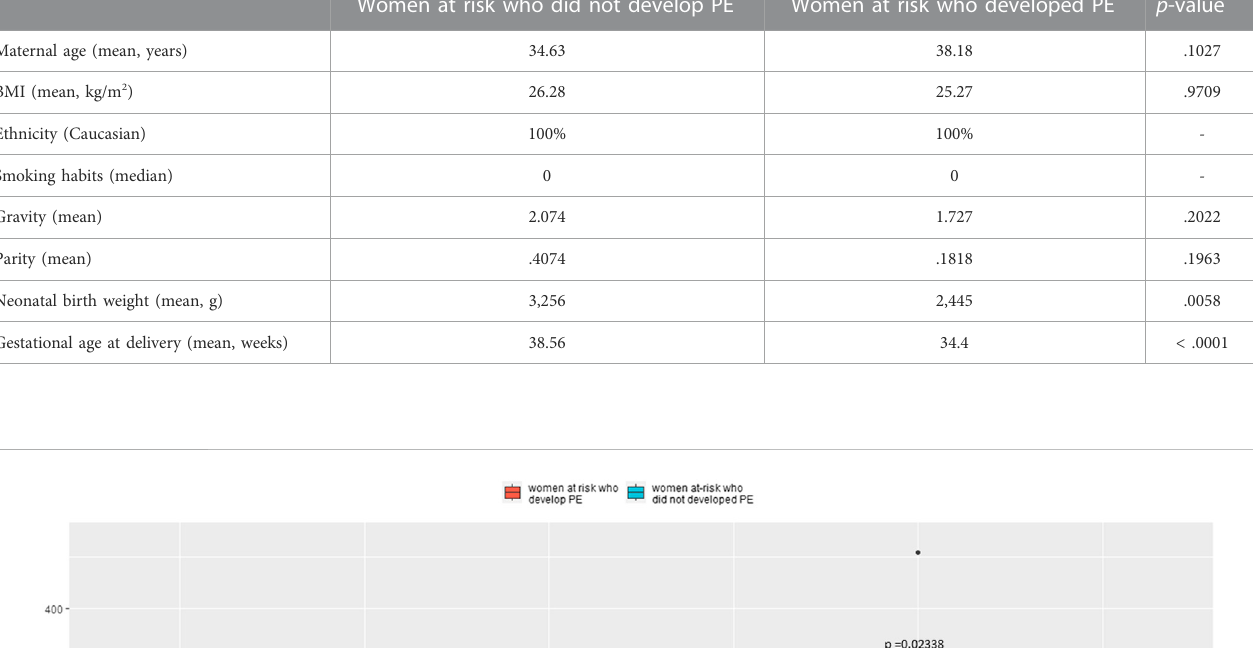
TABLE 1 Anamnestic data on our population of women at risk to develop PE. Women at risk who did not develop PE Women at risk who developed PE